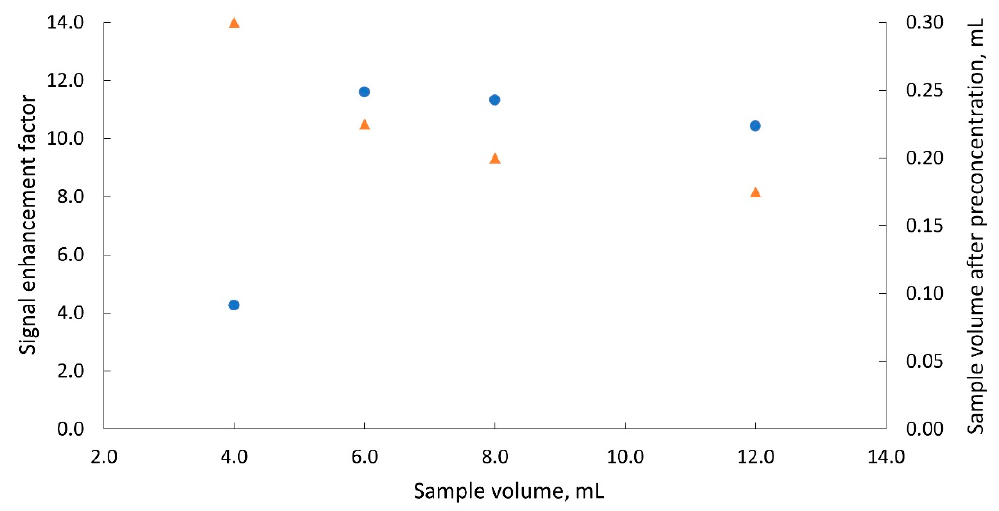
Figure 3. Dependences of the signal enhancement factor ( ● ) and of the sample volume collected after the evaporation process ( ▲ ) (with SD intervals; n = 4) depending on the sample dispensing flow rate.